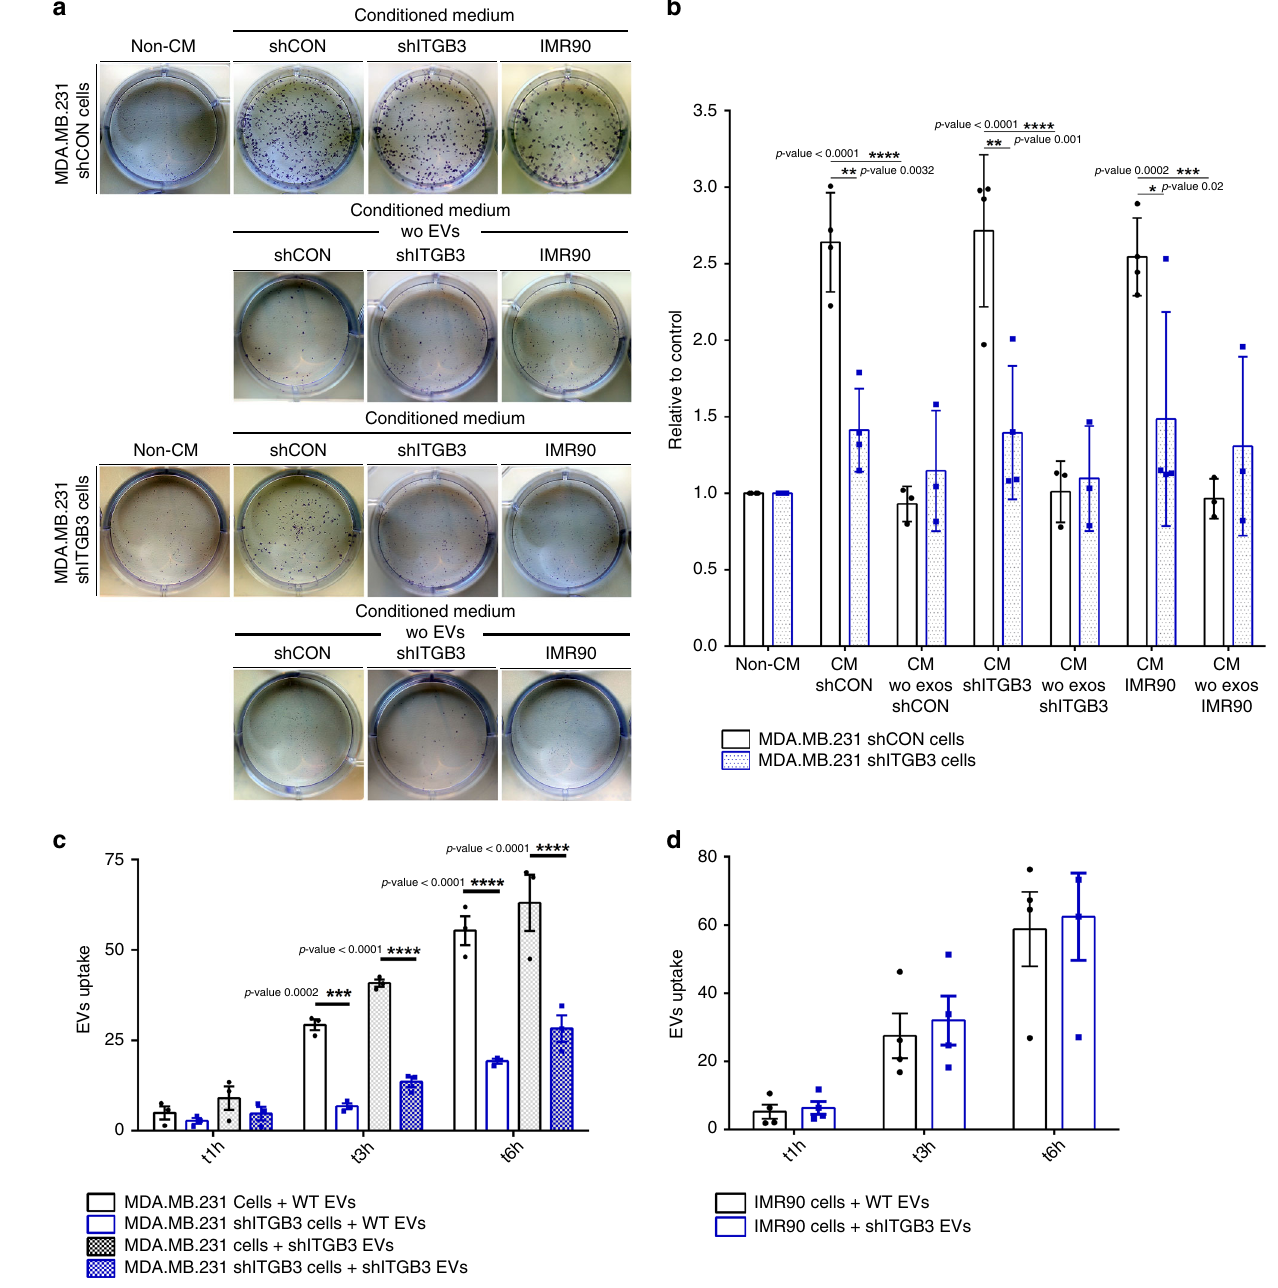
Fig. 1 ITGB3 is required for EV-induced colony formation in MDA.MB.231 cells. a Representative pictures are shown for each cell population